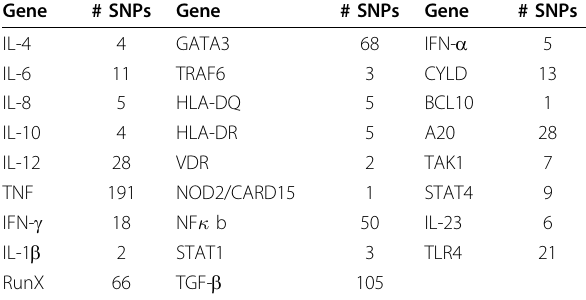
Table 4 Polymorphisms in the Affymetrix GeneChip® Human Mapping 50K Xba Array in Genes Hypothesized to be Associated with Tuberculosis Pathogenesis